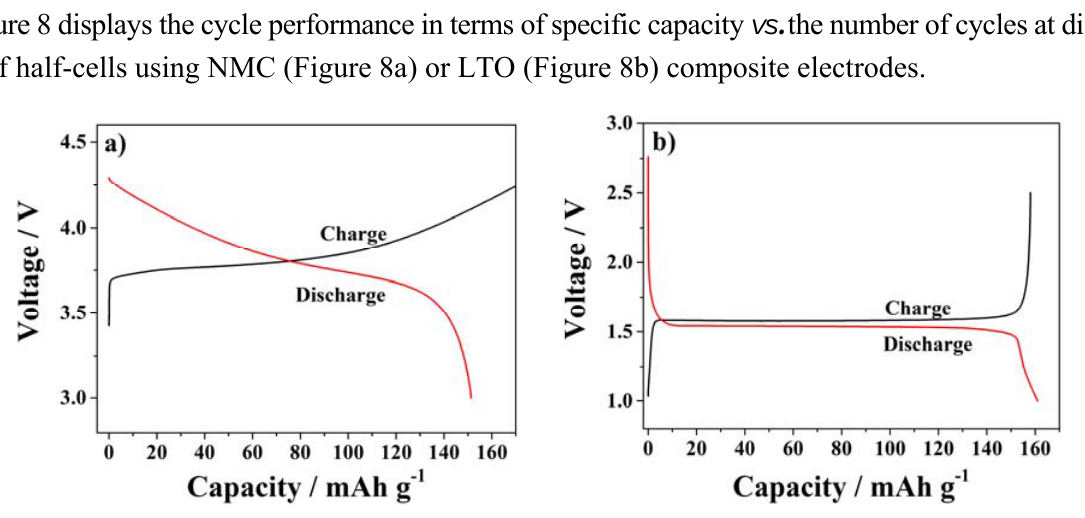
Figure 7. First charge and discharge profile at 0.1C using SiO 2 –HPG membrane as separator in ( a ) NMC; ( b ) and LTO half-cells.